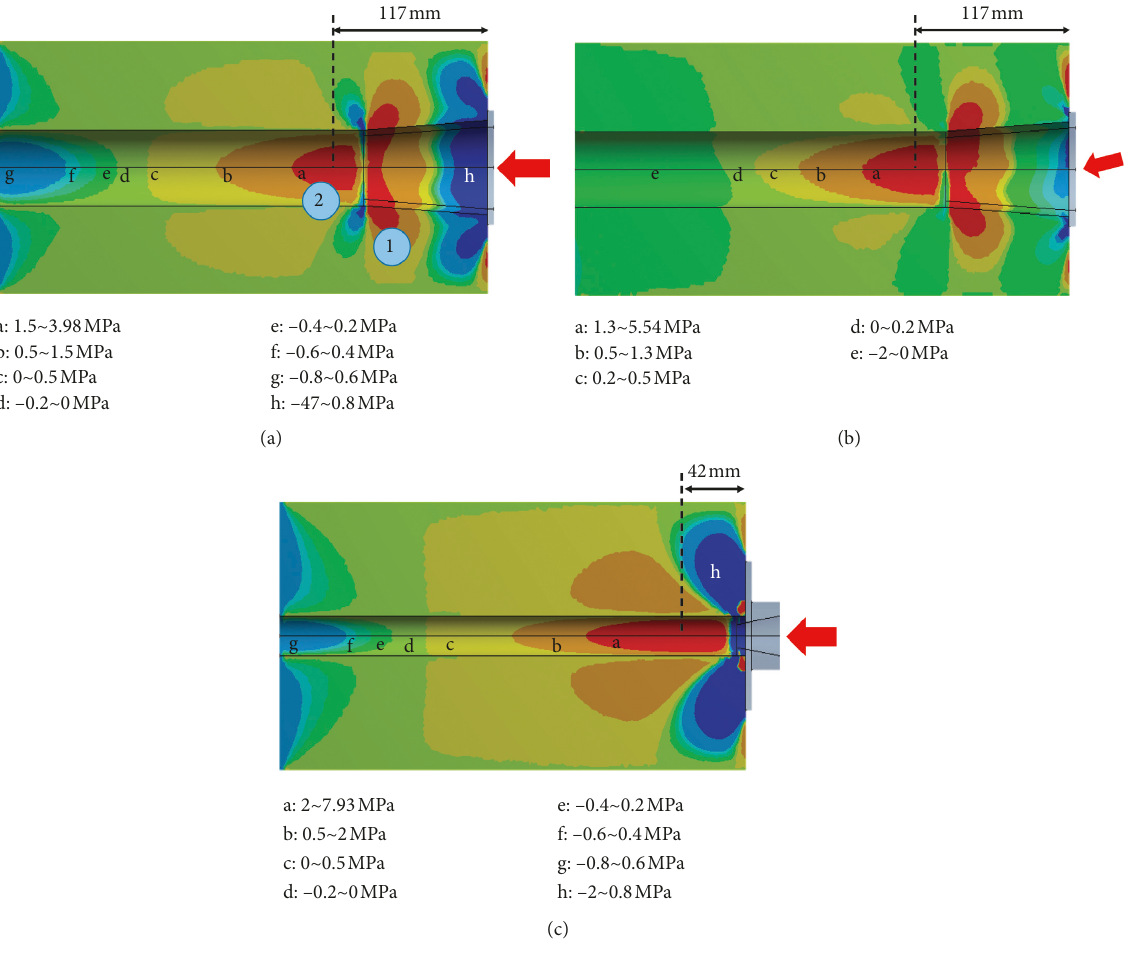
Figure 10: Comparison of normal stresses to investigate the effect of the wedge cavity. (a) Model C, (b) Model CI, and (c) Model